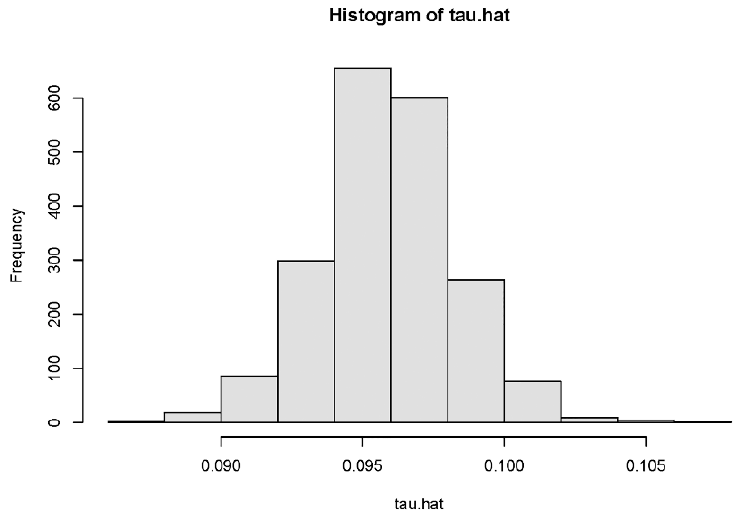
Figure 2. Estimated individual treatment effects of preschool children.